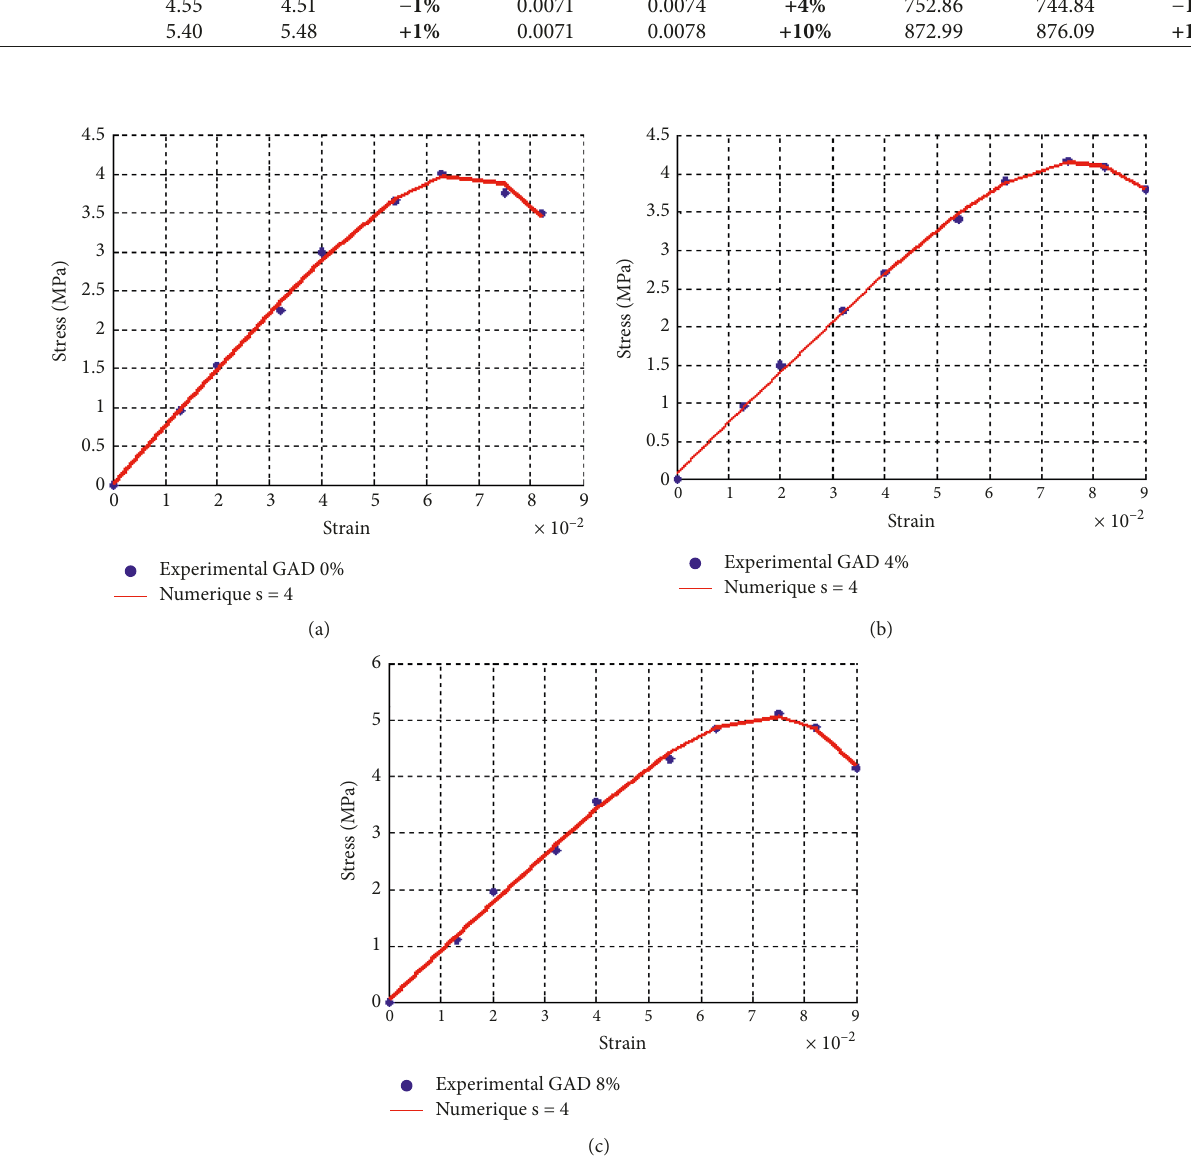
Figure 9: Simple compression stress based on the strain of GAD (0%, 4%, and 8%).